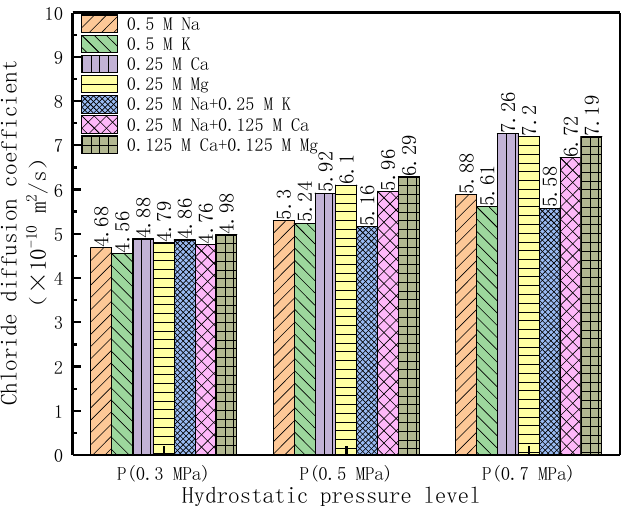
Figure 5. Histogram of chloride diffusion coefficient and the hydrostatic pressure.